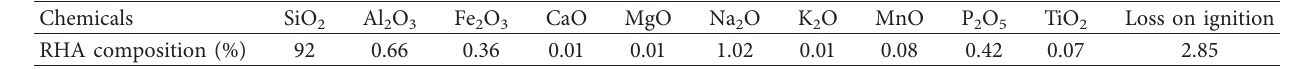
Table 1: Chemical composition of Ethiopian RHA used for this study